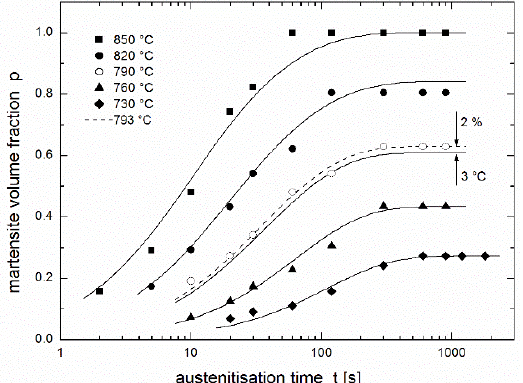
Figure 8. Comparison of the influence of errors in martensite volume fraction determination and austenitisation temperature adjustment on the position of the kinetic curve for 790 °C (the equation of autoinhibition (3) and the modified Arrhenius equation (11) are used). The difference between Equations (12) and (14) is presented in Figure 9 where both values of regression parameter T min (835.3 and 836.8 °C) for p eq = 1 and Ac 1 = 721 °C for p eq = 0 are drawn as additional points. Full line representing Equation (14) finishes in zero